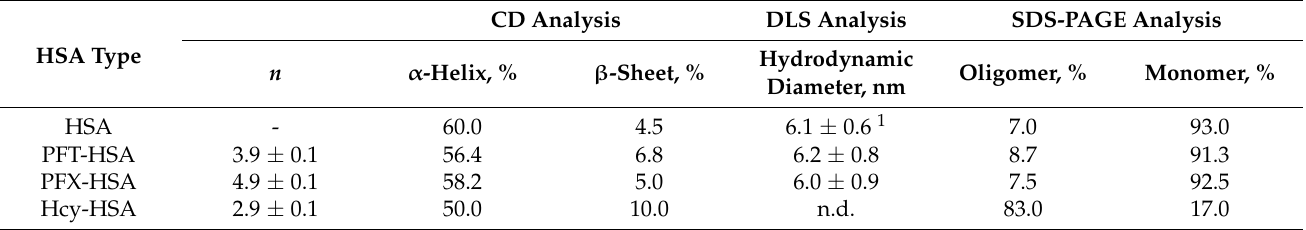
Table 3. Fluorinated HSA characteristics.